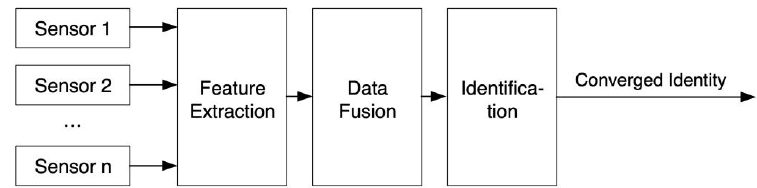
Figure 2. Data-level fusion